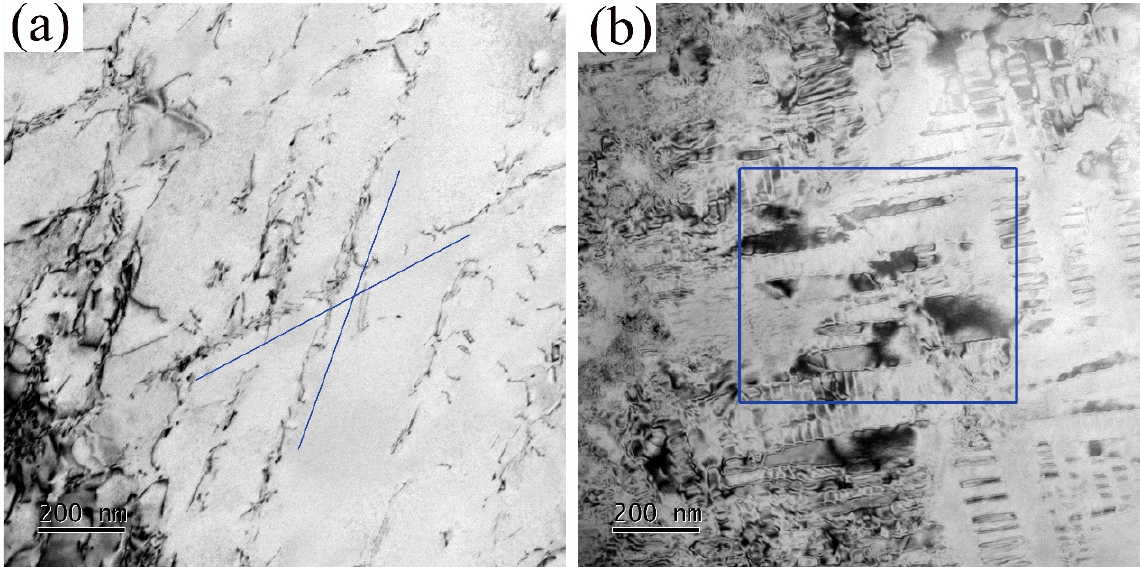
Figure 6. The TEM structure of water-quenched ( a ) and furnace-cooled ( b ) samples with 11% Al addition after tensile strain of 10%.